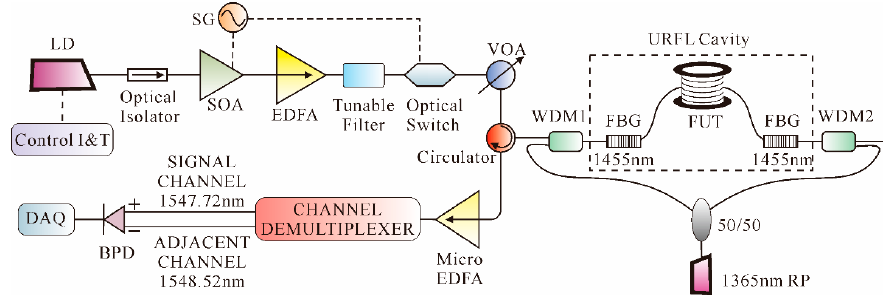
Figure 11. Experimental setup of Φ -OTDR using an URFL cavity, adapted from Martins et al.